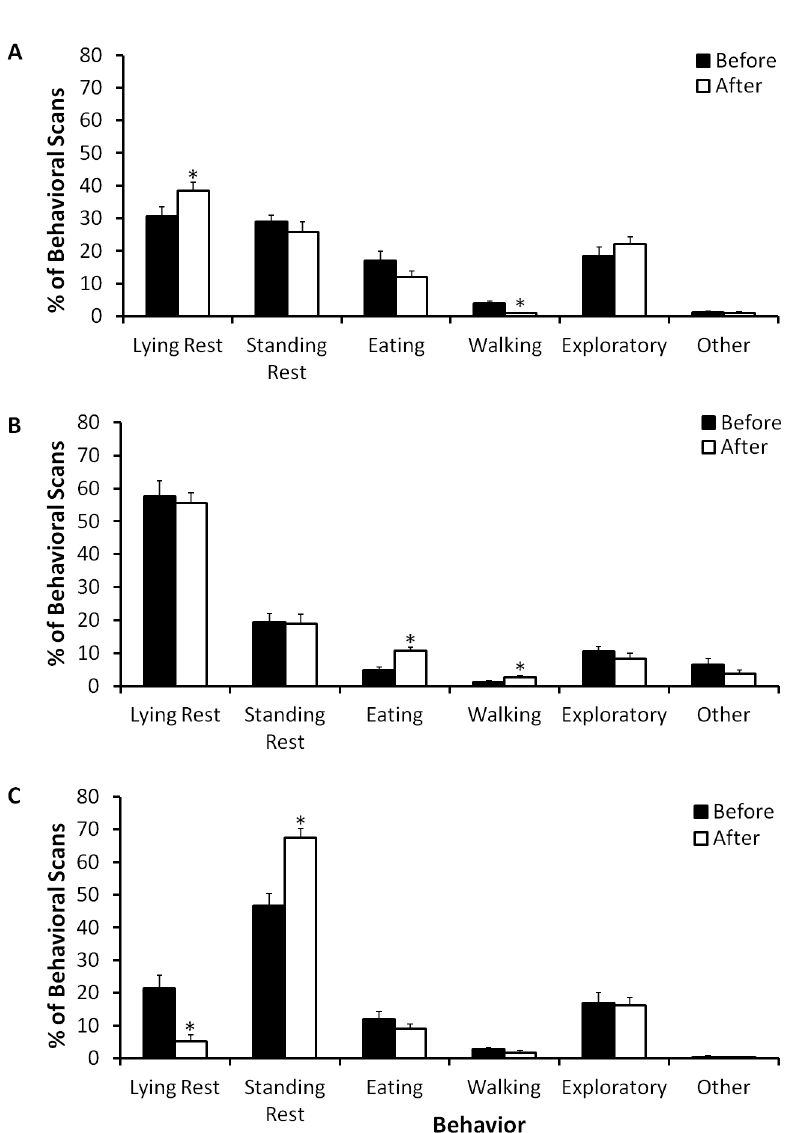
Fig 3. Nocturnal indoor activity budgets (mean ± SE) of three female African elephants (A: Asali; B: Gina; C: Tyranza) before and after installation of rubberized flooring in their indoor facilities. Indoor behavioral data collection occurred from approximately 17:30 to 8:00 h, with data collection ending when husbandry by an animal keeper began. During renovations the elephants were not allowed indoors. An asterisk ( * ) indicates that the mean for after renovations is outside the 95% CI for the data before renovations.